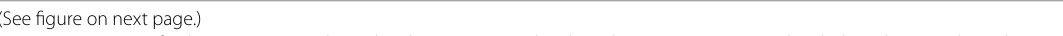
constant sedimentation rates of 30 cm/kyr and 18 cm/kyr for the intervals above and below the Byk-E tephra layer, respectively. Based on this age model, the ages of tephra A and tephra C are 772.6 ka and 777.5 ka, respectively.